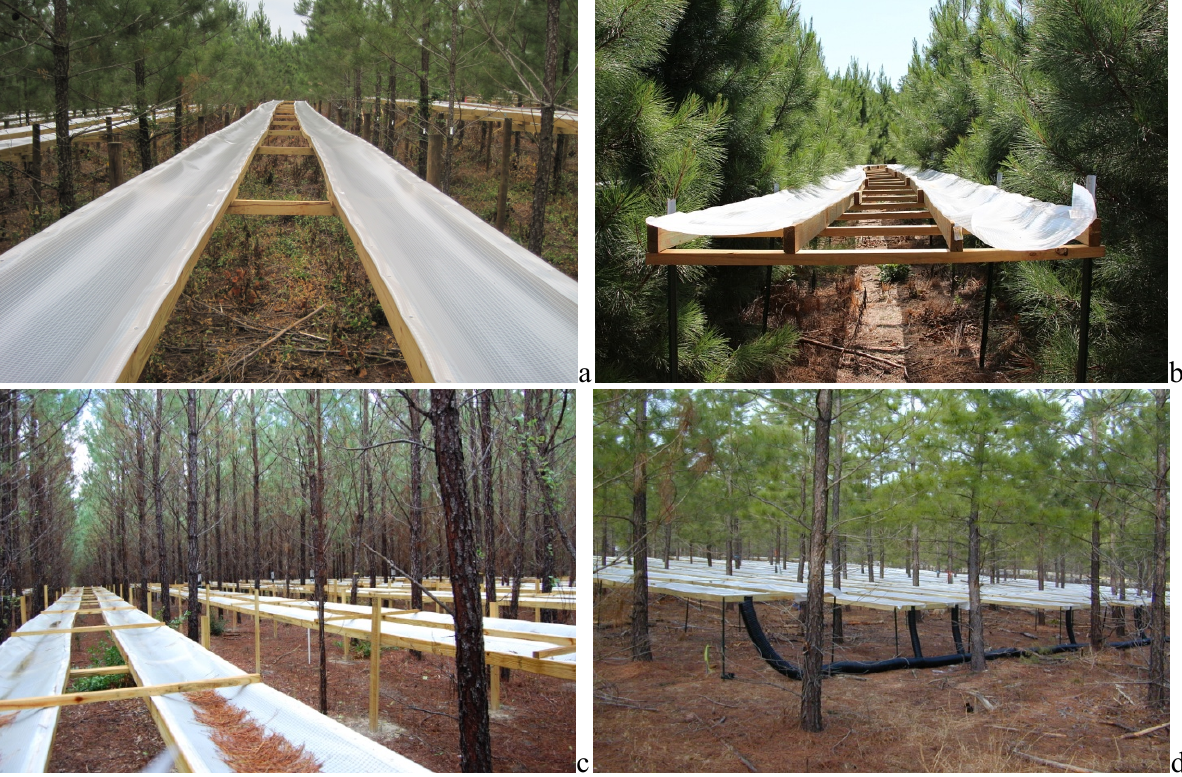
Figure 2. Recently installed (2012) throughfall excluders at the site in Taliaferro, Co., GA ( a ), McCurtain Co, OK, ( b ), Taylor Co., FL ( c ), and Buckingham Co., VA ( d